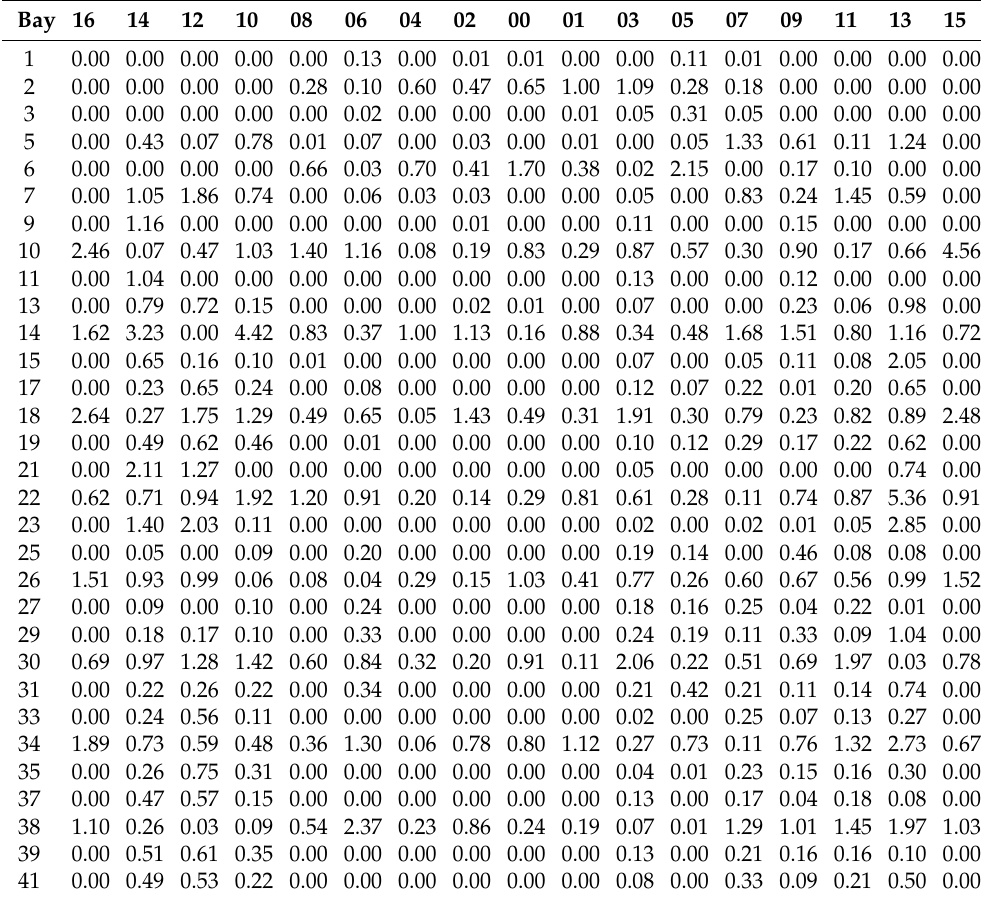
Figure 12. Result comparison between OSP interface and model prediction in graphical top overview. The red color means that the lashing force value is over 100%, the yellow color is over 90%, otherwise the green color is depicted. Table 5. Difference between OSP interface and model prediction in percentage scale.